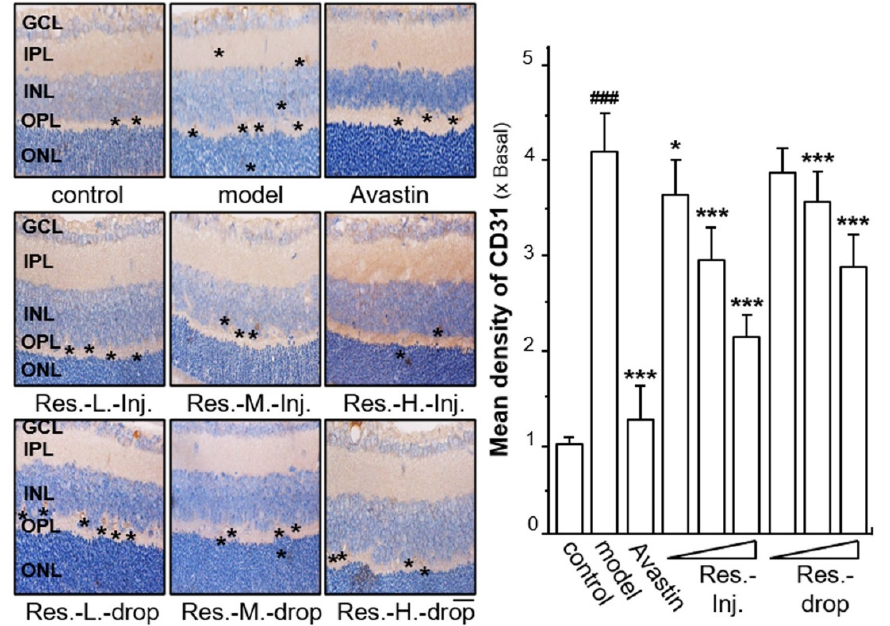
Figure 4. Resveratrol suppresses hyperoxia-induced expressions of CD31 in retinal ROP model . Retinal tissues were immuno-stained with the CD31 antibody and stained by DAB dye. The positive area is brown or yellowish brown (left). * shows the expressed part of the target protein. Image-Pro Plus version 6.0 software was used for the quantification of CD31 density (right). Results are expressed as the fold of change to control (x basal), where the control group (no drug) was set as 1, Mean ± SEM, where n = 6; ### p < 0.001 vs. the control group; * p < 0.05; *** p < 0.001 vs. the model group. Bar = 25 μ m.